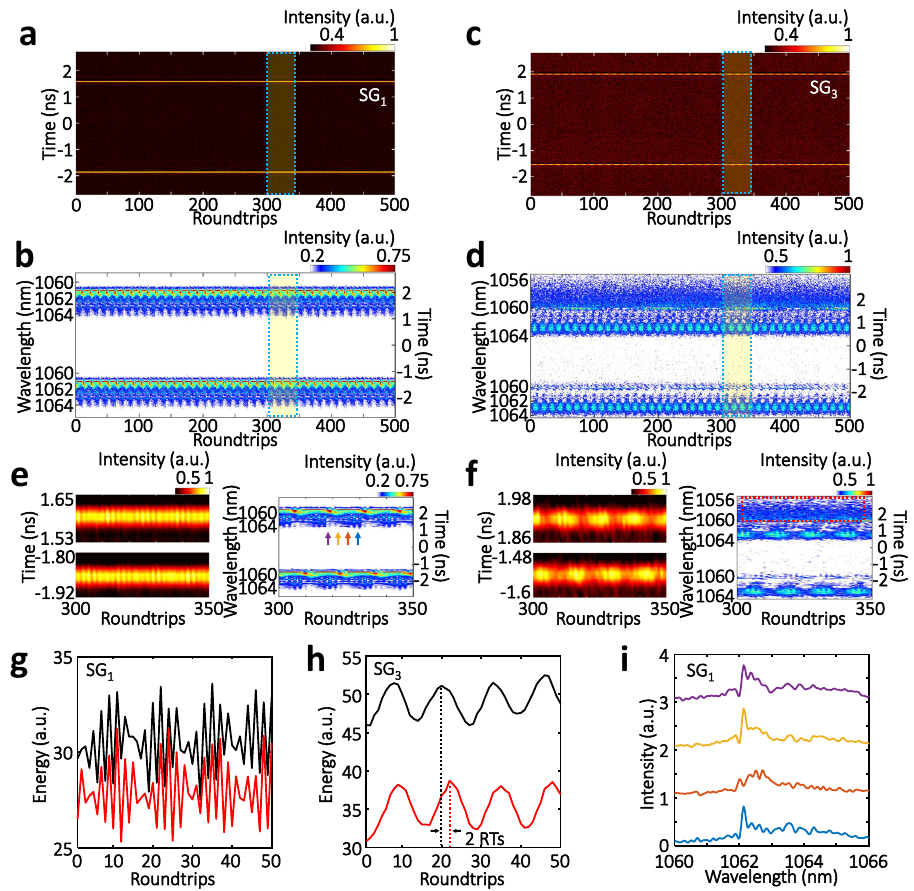
Fig. 5 Internal breathing dynamics of 3D dissipative solitons. a , c Temporal evolutions of coexisting two pulses in speckle grains SG 1 and SG 3 , respectively. b , d Corresponding spectral evolutions. e , f Close-ups of the temporal (left) and spectral (right) evolutions of a , b and c , d , respectively, as indicated in a – d . g , h Energy evolutions in the spectral domain (right panels of e and f ). i Snapshot spectra as indicated in the right panel of e